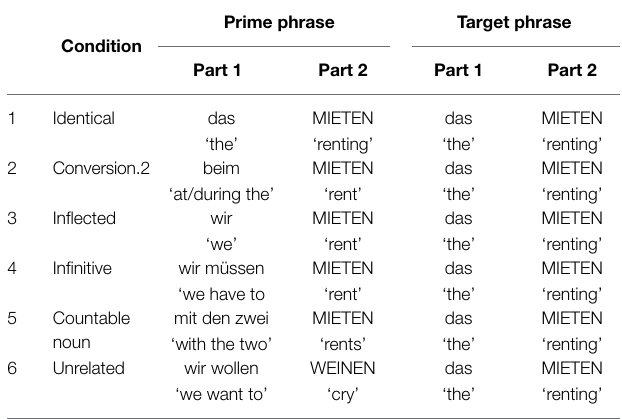
TABLE 3 | Experiment 2: experimental conditions and examples of prime and target phrases.